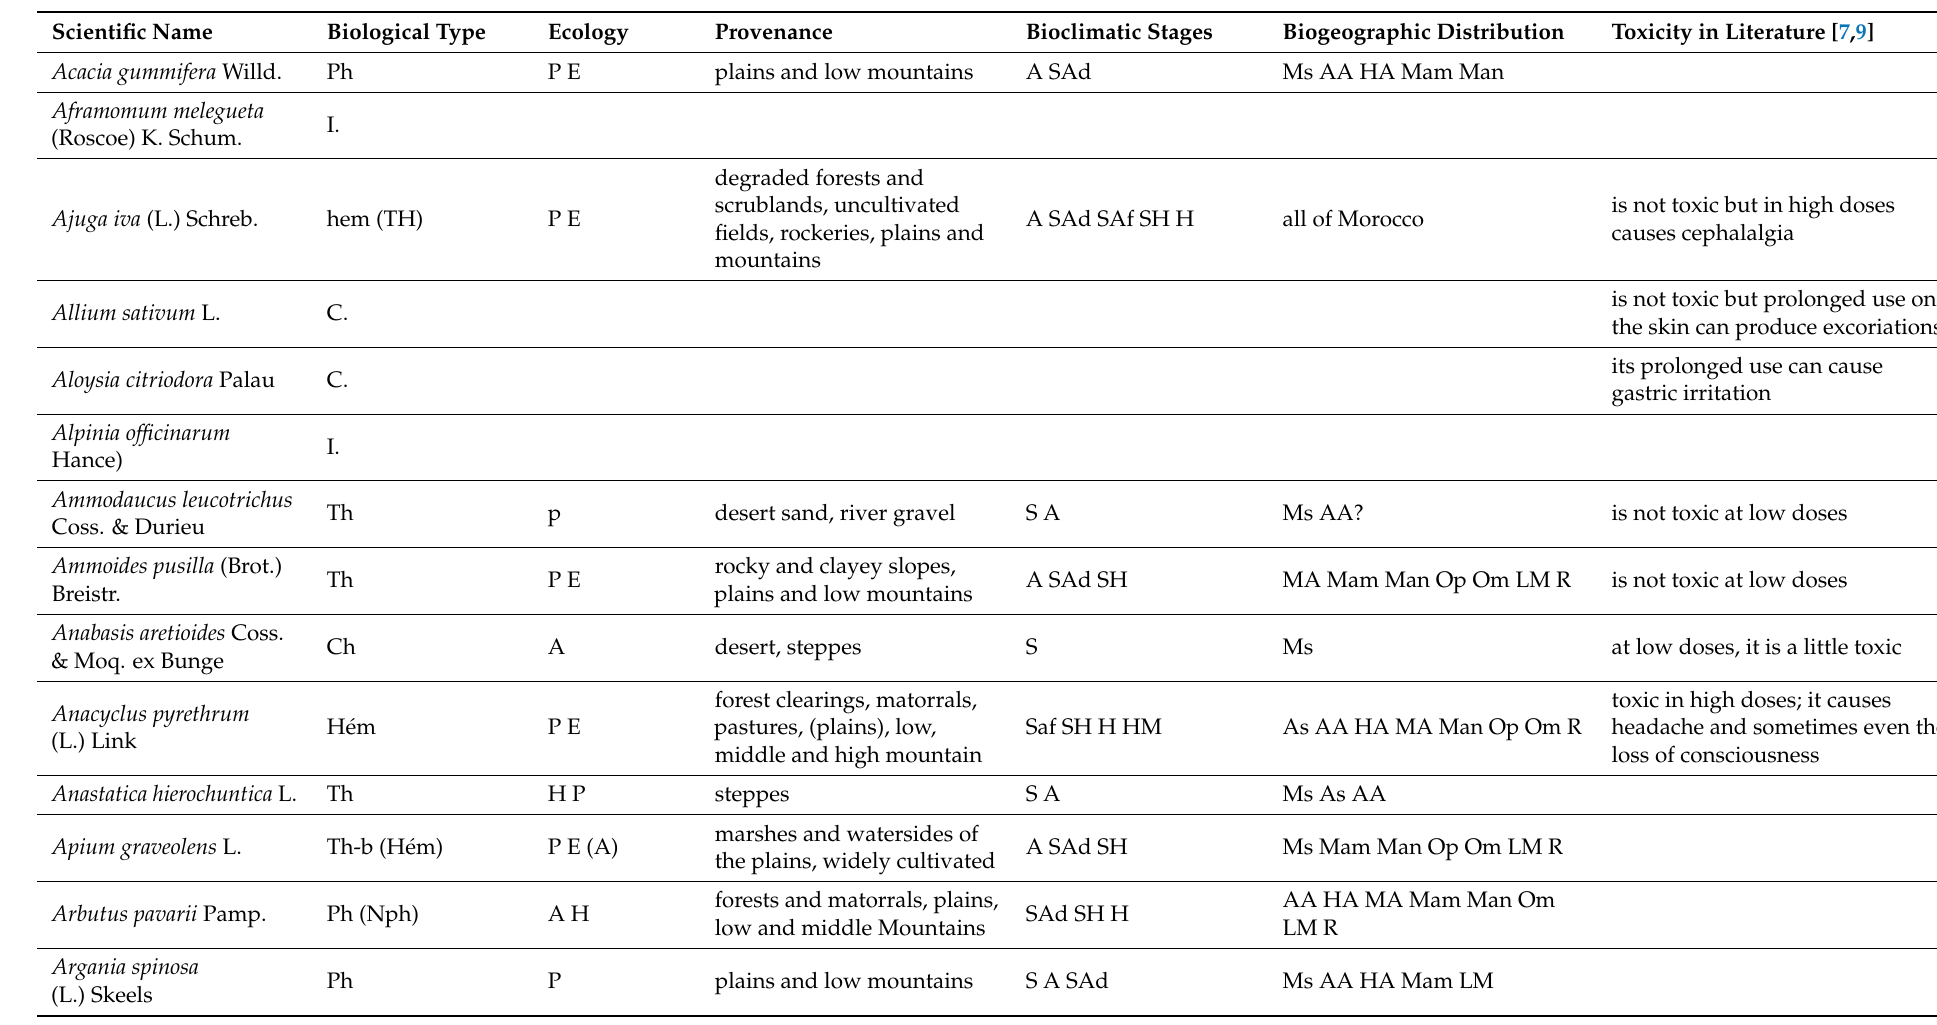
Table A1. Medicinal plants of Eeastern Morocco by THs and their descriptions in the